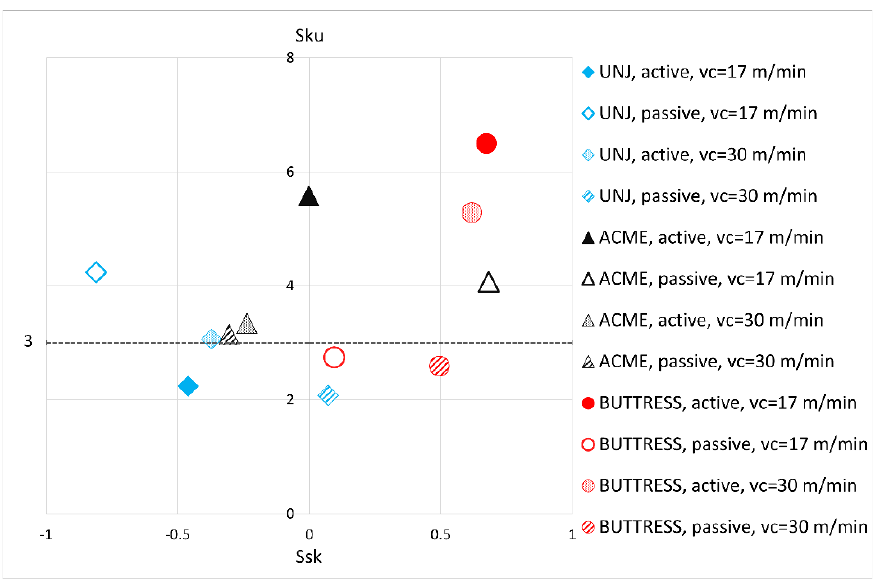
Figure 6. Sku – Ssk map for the measured surfaces. Figure 6. Sku–Ssk map for the measured surfaces.